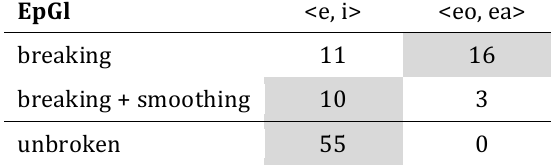
Table 8 : Mismatch of breaking and smoothing in the Standard Theory. The theory predicts that the attested forms would only fall in the grey cells.